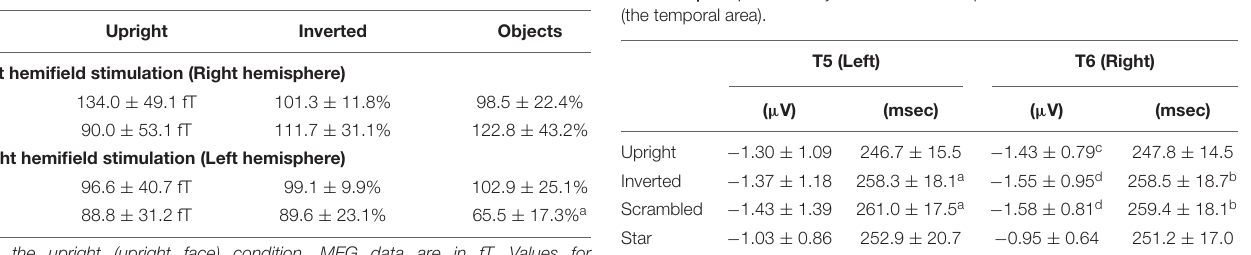
Means and SD for upright, inverted, scrambled, and star [adopted from Miki et al. (2009)]. a p < 0.01 compared with upright. b p < 0.05 compared with upright. c p < 0.05 compared with star. d p < 0.01 compared with star. SD, standard